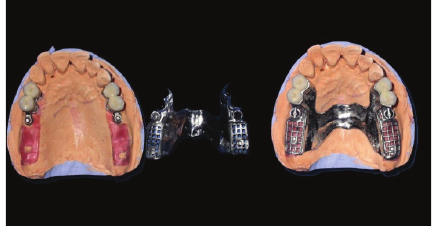
Figure 5: Metal framework on the model.